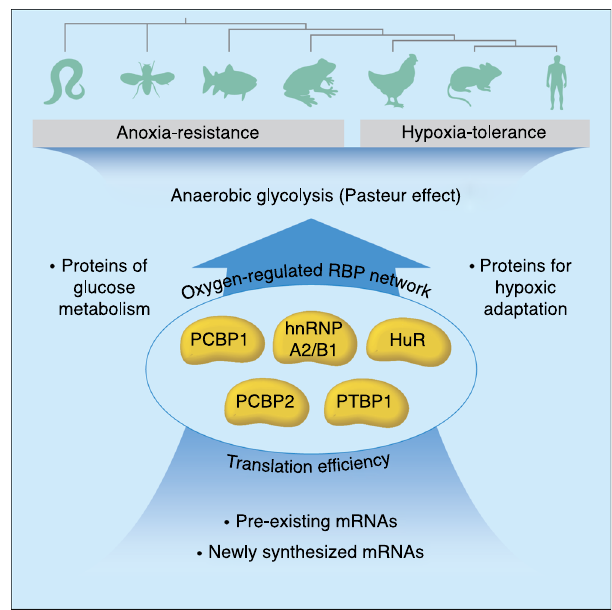
Fig. 7 A network of RBPs activates anaerobic glycolysis through translation ef fi ciency. An abstract representation of hypoxia-activated RBPs that activate anaerobic metabolism through mRNA translation ef fi ciency of glycolytic proteins. This system enables hypoxic tolerance across